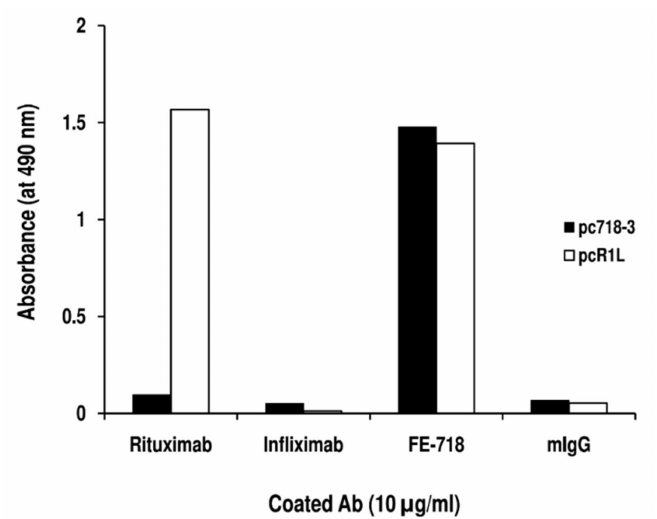
Figure 4. Reactivity of Rituximab with the mAb FE-341-specific phage clone pc718-3. Supernatants from pc718-3 and pcR1L phage clones were diluted 16-fold and added to wells previously coated with mAb or mouse IgG (mIgG). After a 4h incubation, the antibody-phage clone interaction was detected with HRP-conjugated anti-M13 mAb. The data are representative of two